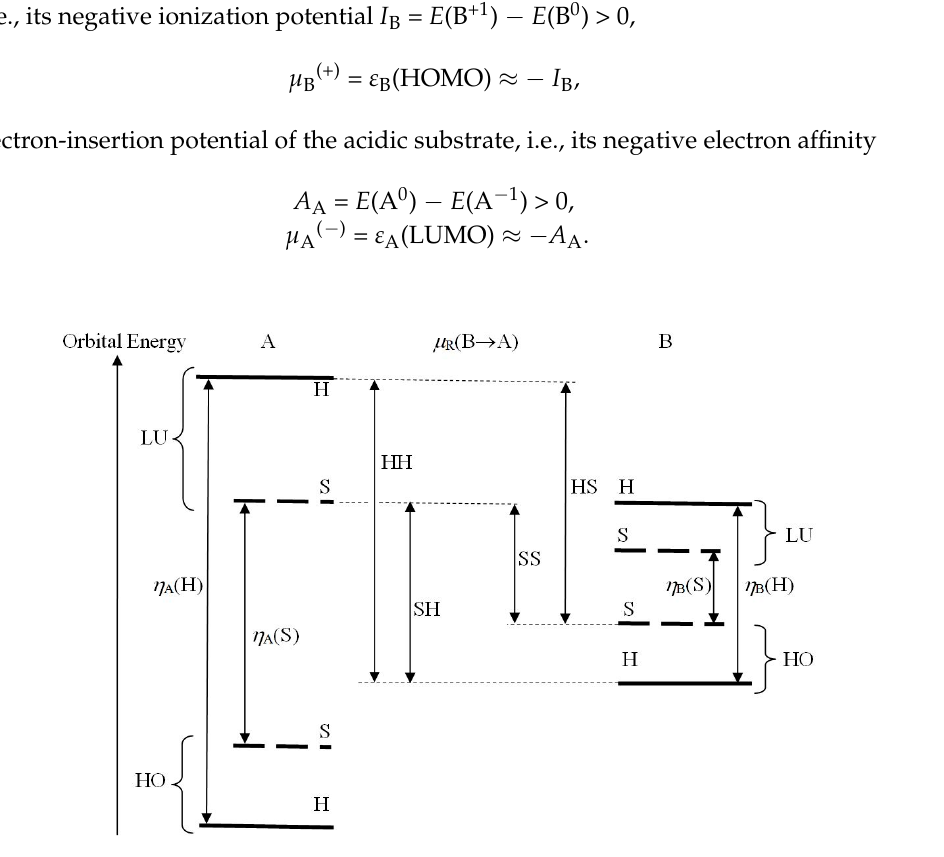
Figure 4. Schematic diagram of the in situ chemical potentials μ CT (B → A), determining the effective internal charge transfer (CT) from basic (B) reactant to its acidic (A) partner in A–B complexes, for their alternative hard (H) and soft (S) combinations. The subsystem hardnesses reflect the HOMO-LUMO gaps in their orbital energies.